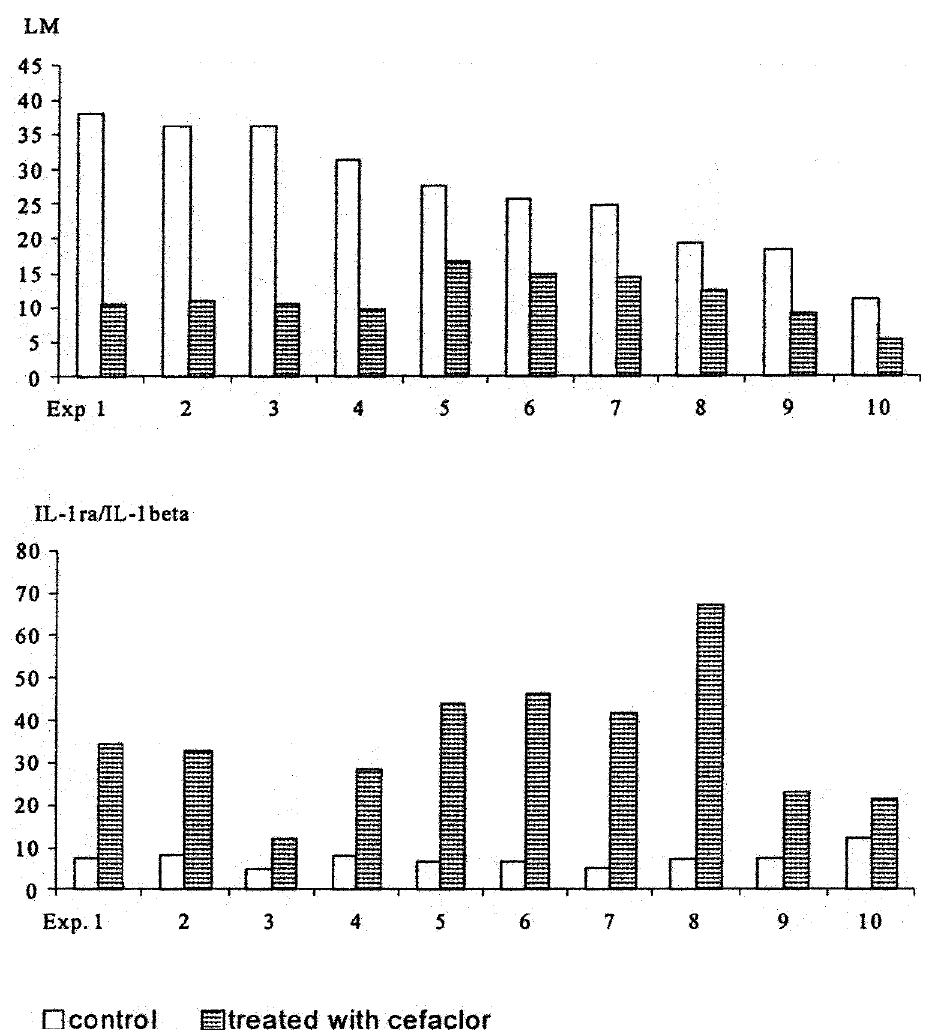
FIG. 1. Values of LM indices depend on the ratio of IL-1ra/IL-1 b concentration in peripheral blood mononuclear cell microcultures treated with cefaclor.